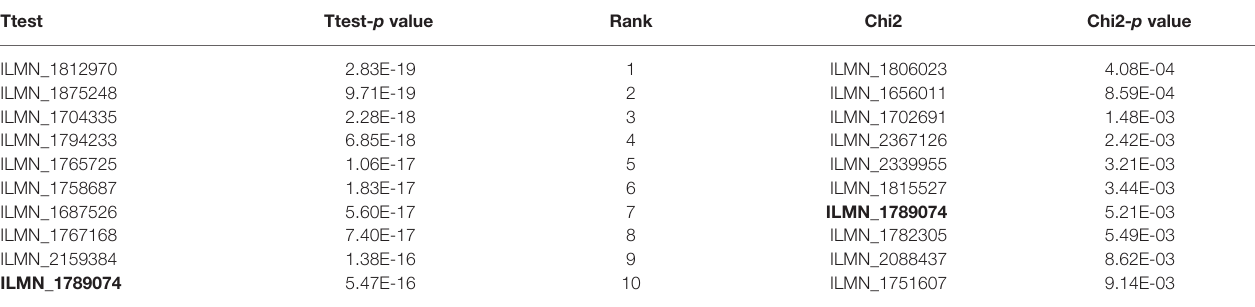
TABLE 1 | The top-10 features ranked by Ttest and Chi2. The two columns “Ttest” and “Chi2” gave the names of the ranked features. Ttest Ttest- p value Rank Chi2 Chi2- p value